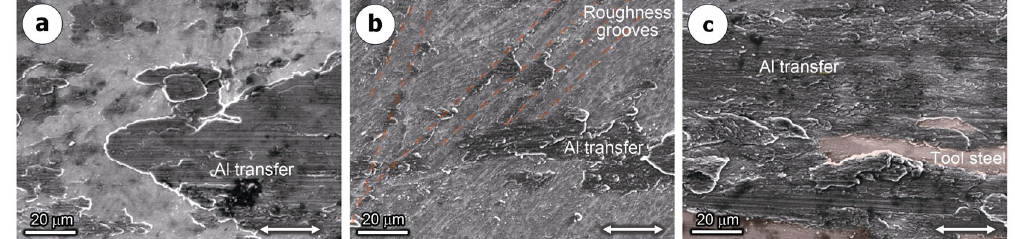
Fig. 6 SEM micrographs of (a) tool steel A, (b) tool steel V, and (c) tool steel O surface obtained from the dry sliding test, showing the heavy aluminium transfer layer ( ↔ indicates the sliding